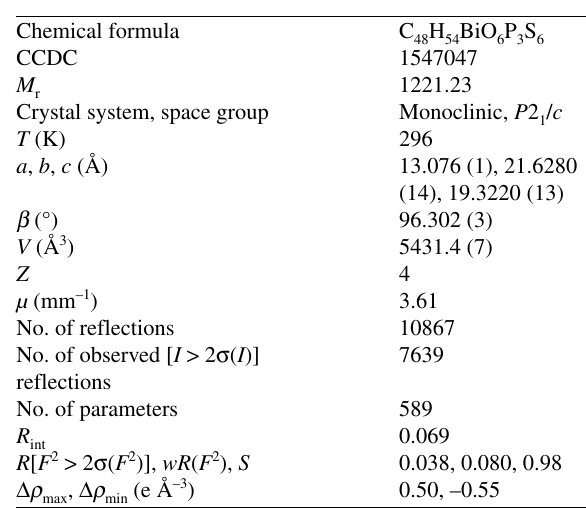
Table 1. Crystal data and structure refinements for [{ (3,5-